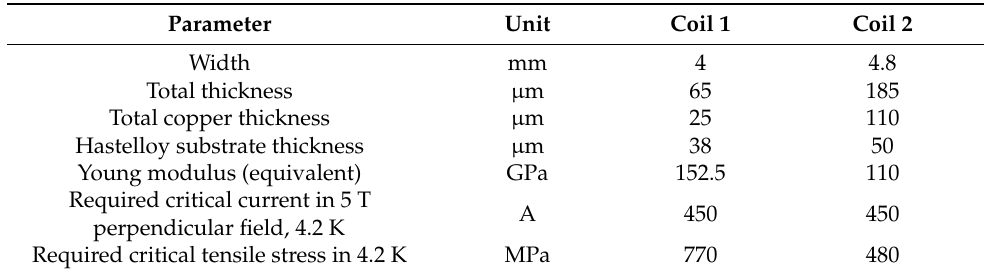
Table 1. REBCO Conductor